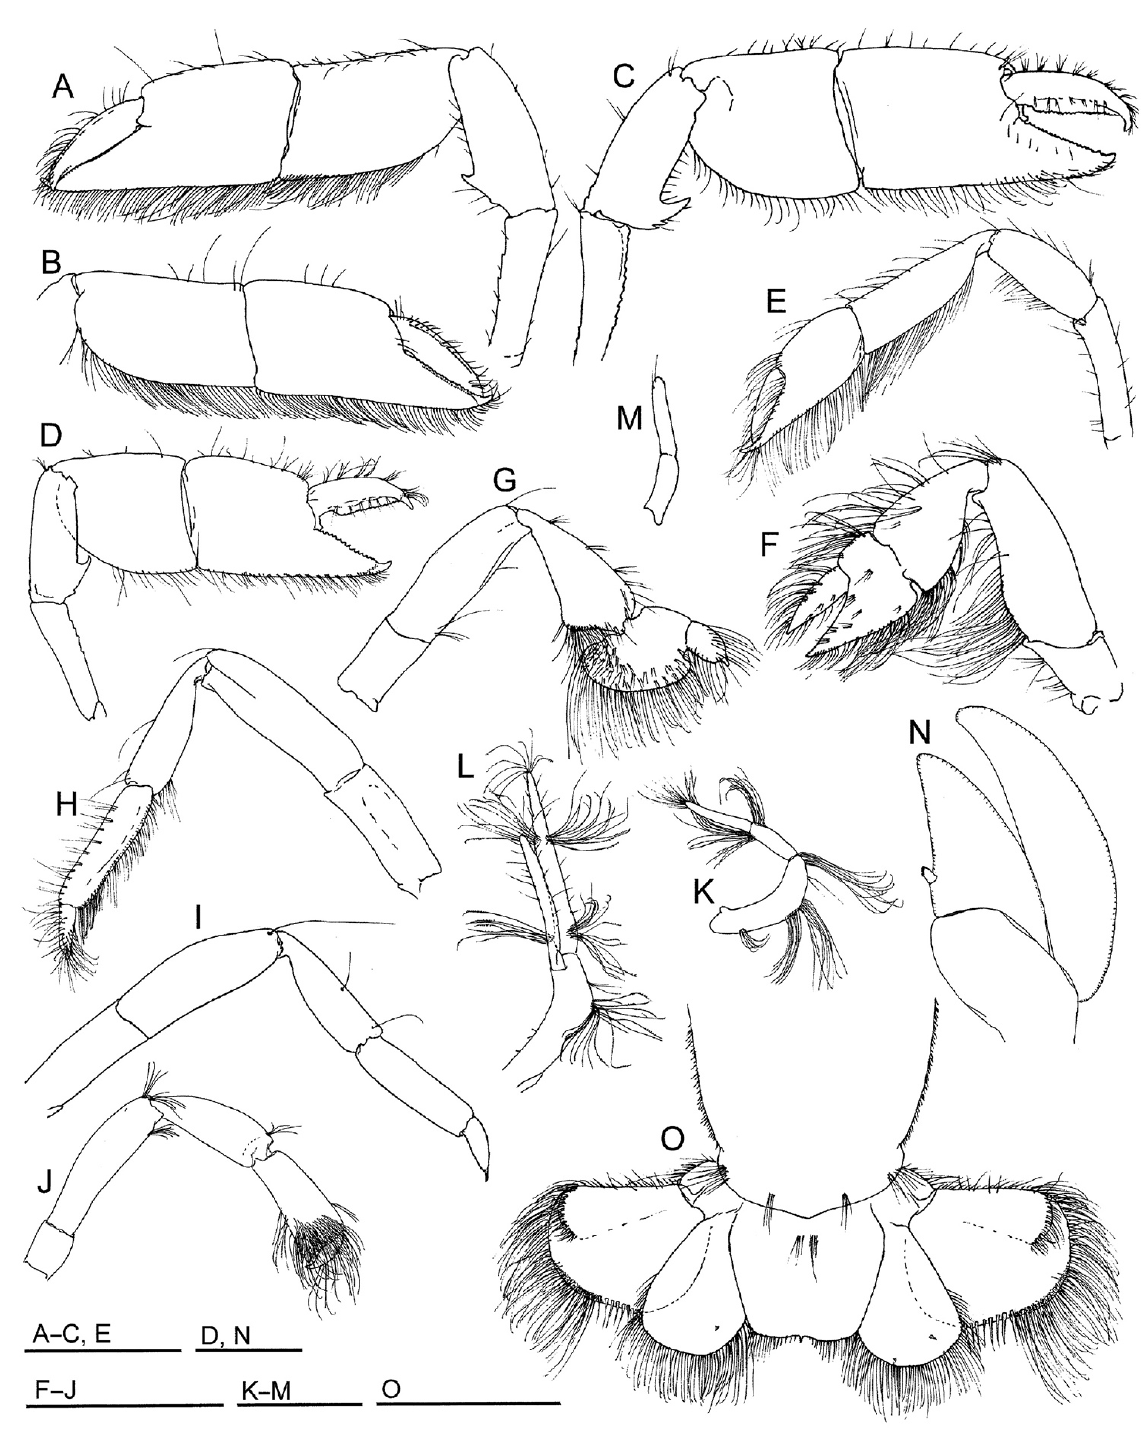
Figure 5. Gilvossius fredericqae n. sp. A , B , E–G , K , L , N , O , female holotype, pocl 4.0 mm, northwestern Gulf of Mexico, off Texas, 98 m depth (USNM 1607374 = ULLZ 17894); C, H–J , ovigerous female paratype, pocl 3.6 mm, northwestern Gulf of Mexico, off Texas, 131 m depth (USNM 1607376 = ULLZ 17903); D , juvenile male paratype, pocl 2.2 mm, northwestern Gulf of Mexico, off Texas, 125 m depth (USNM 1607379 = ULLZ 17906); M , male paratype, pocl 2.7 mm, northwestern Gulf of Mexico, off Texas, 106 m depth (USNM 1607375 = ULLZ 17495). A , major cheliped of female, right, internal; B , same, external; C , major cheliped of ovigerous female, left internal; D , major cheliped of juvenile male, internal; E , minor cheliped of female, left, external; F , second pereopod, left, external; G , third pereopod, right, external; H , fourth pereopod, right, internal; I , same, without setae, external; J , fifth pereopod, right, external; K , first pleopod, female, right, external; L , second pleopod, female, right, external; M , first pleopod, male, right, external; N , third pleopod, right, anterior; O , telson and uropods. Scale bars = 2.0 mm ( A–C, E, F–J, O ), 1.0 mm ( D, K, M, N